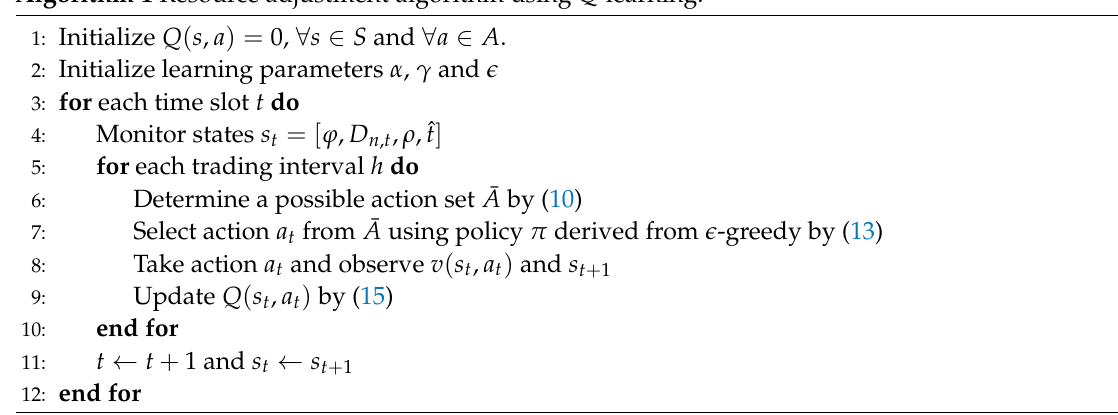
Algorithm 1 Resource adjustment algorithm using